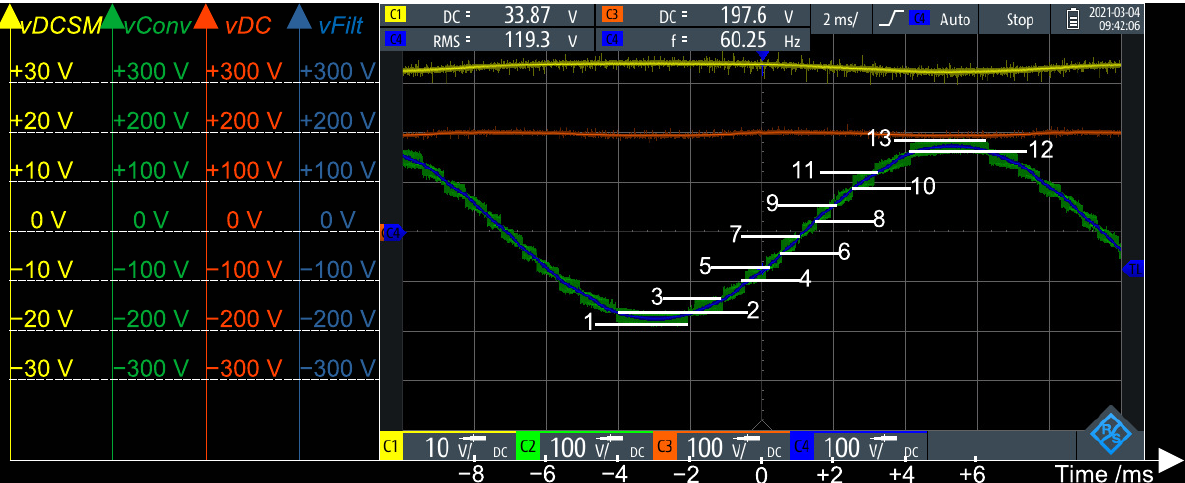
Figure 11. Open loop operation of the Modular Multilevel Converter (MMC) topology (bi-phase, 4 arms, N = 6 SMs/arm ⇒ 13